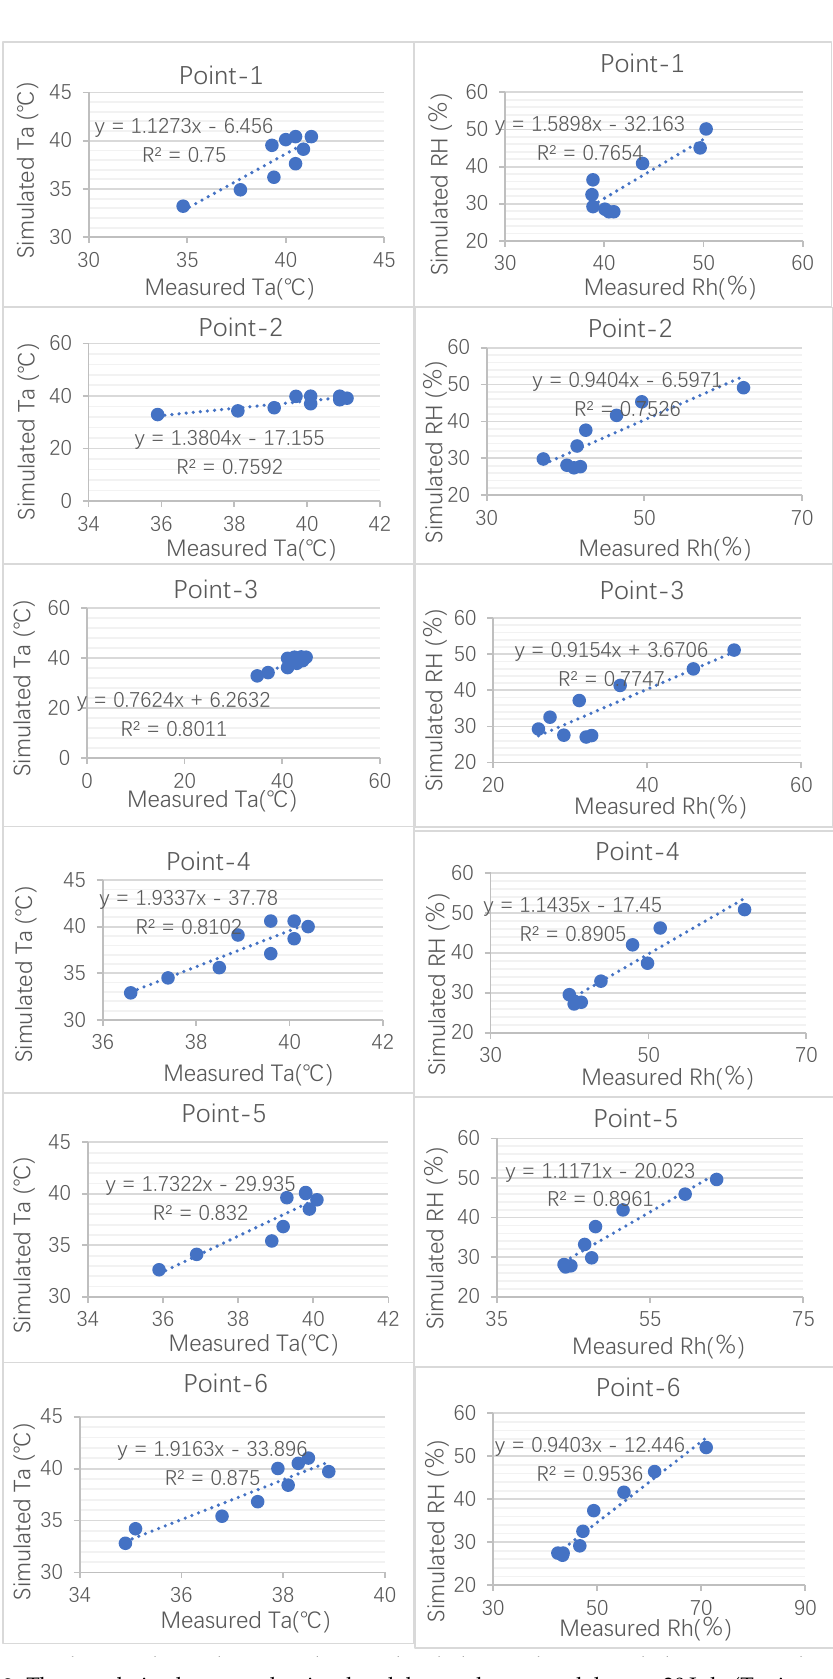
Figure 10. The correlation between the simulated data and measured data on 30 July (Ta air temperature, RH relative humidity) [18].